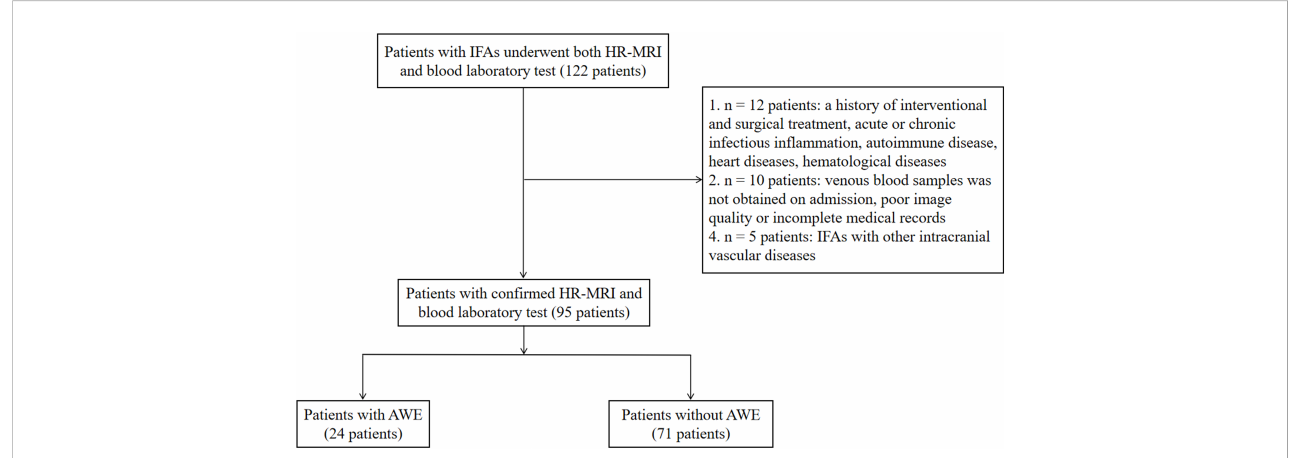
FIGURE 2 Patient in fl ow chart. AWE, aneurysmal wall enhancement; HR-MRI, high-resolution magnetic resonance imaging; IFAs, intracranial fusiform